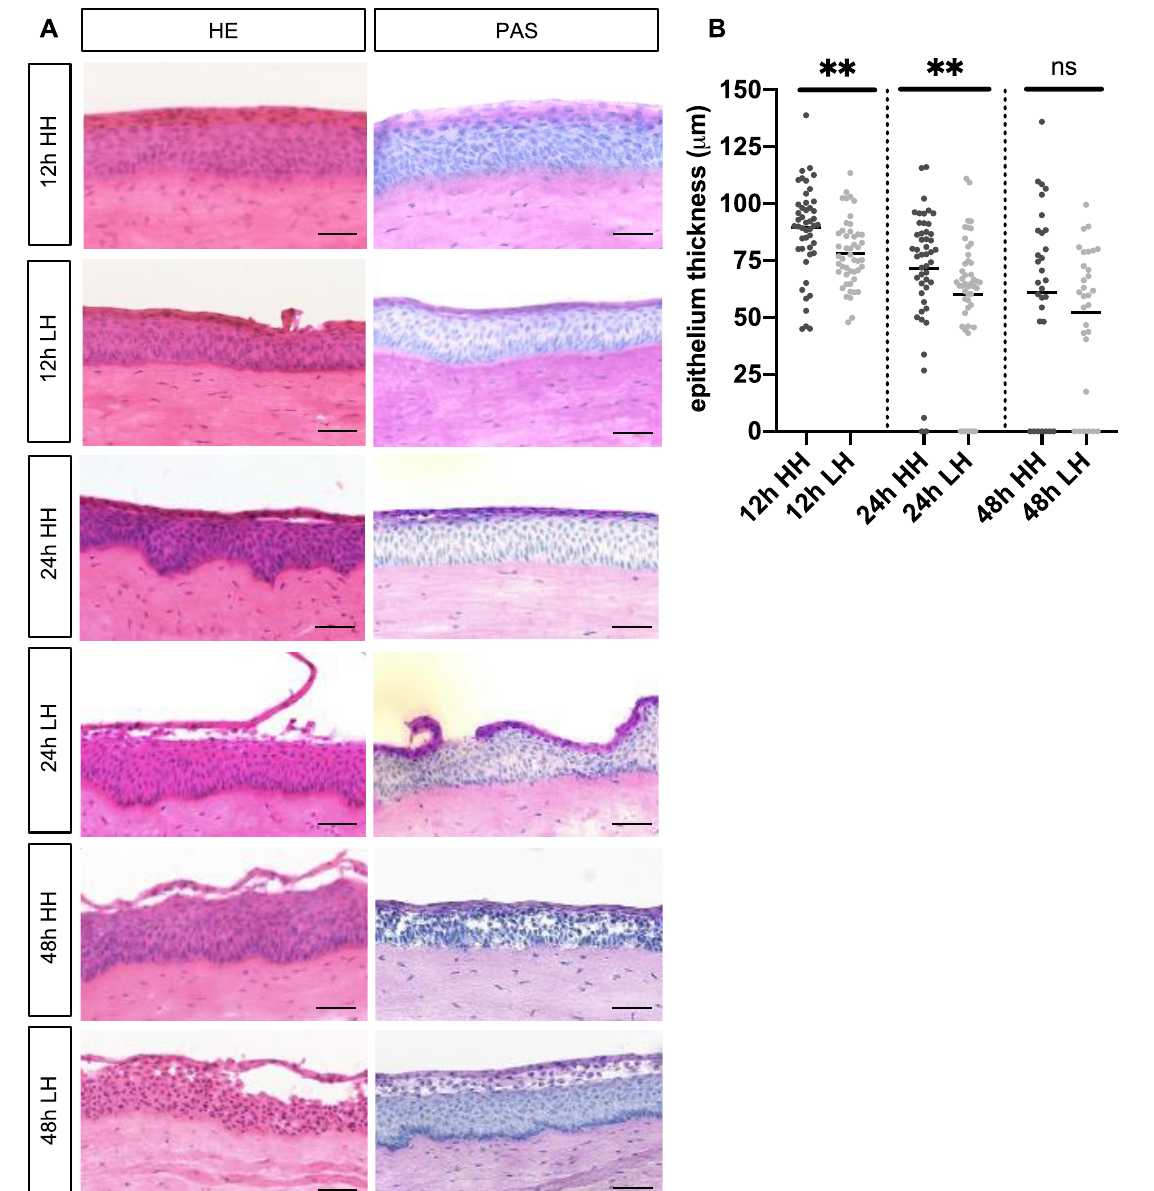
Figure 1. Low humidity (LH) causes corneal damage and corneal thinning. ( A ) Representative images of porcine corneas subjected to LH and high humidity (HH), respectively, for different time points. Samples incubated at LH for 12 h stained with HE and PAS exhibited small desquamation of surface corneal epithelial cells in comparison to controls. Samples submitted to LH for 24 h stained with HE and PAS demonstrated epithelial damage and detachment of glycoprotein layer when compared to HH samples. Samples submitted to LH and to HH for 48 h stained with HE and PAS demonstrated epithelial damage and detachment of glycoprotein layer. ( B ) Epithelial thickness of samples incubated at LH for 12 h (78.29 µm ± 2.11) was significantly reduced in comparison to the 12 h HH group (89.77 µm ± 3.17; p = 0.003) ( n = 8 for 12 h LH/ n = 8 for 12 h HH). Moreover, epithelial thickness of samples submitted to LH for 24 h (60.34 µm ± 3.98) was significantly reduced when compared to their controls (71.80 µm ± 3.75; p = 0.009) ( n = 7 for 24 h LH/ n = 8 for 24 h HH). No significant different was observed between samples submitted to LH (52.09 µm ± 5.71) and HH (60.90 µm ± 7.21; p = 0.342) for 48 h ( n = 5 for 48 h LH/ n = 5 for 48 h HH). Scale bar = 50 µm. LH: low